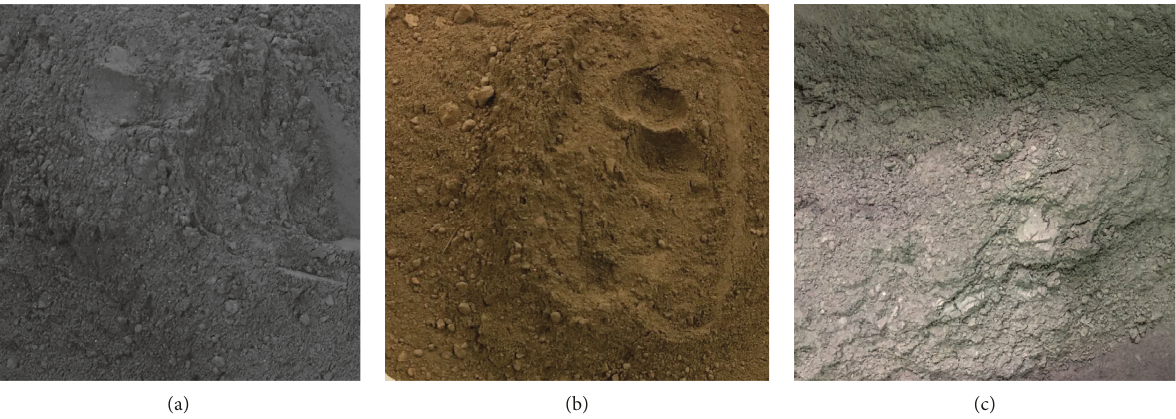
Figure 2: Physical appearance of (a) tailings A, (b) tailings B, and (c) stone powder.